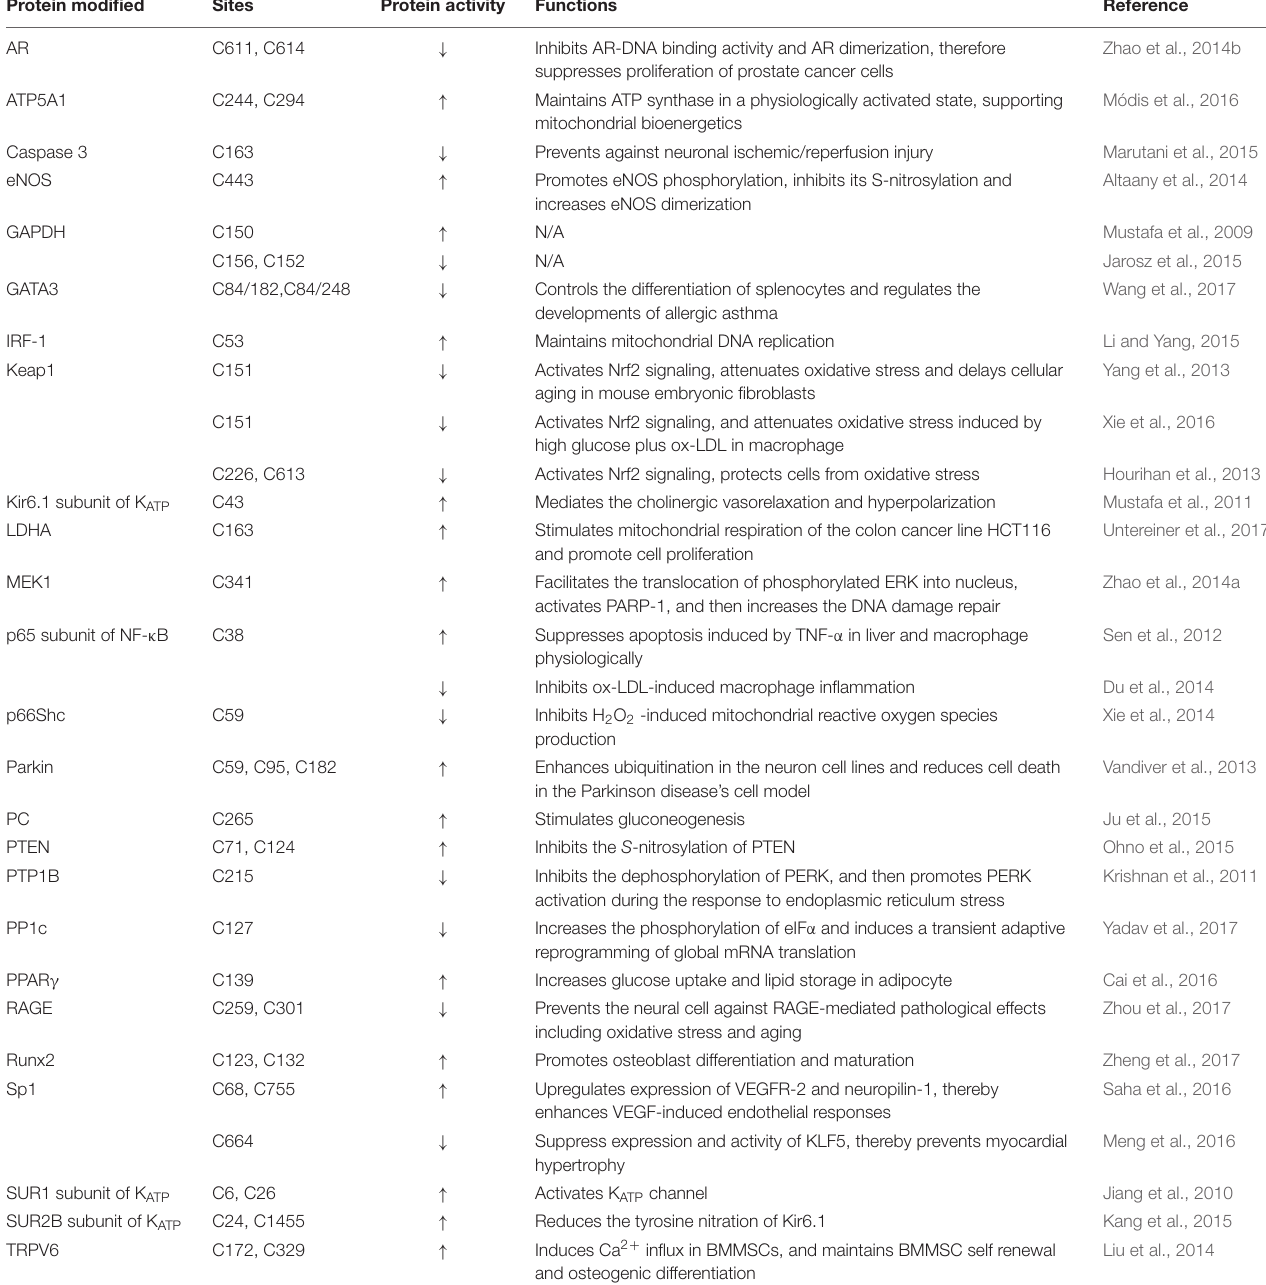
TABLE 1 | Examples of sulfhydrated proteins listed in alphabetical